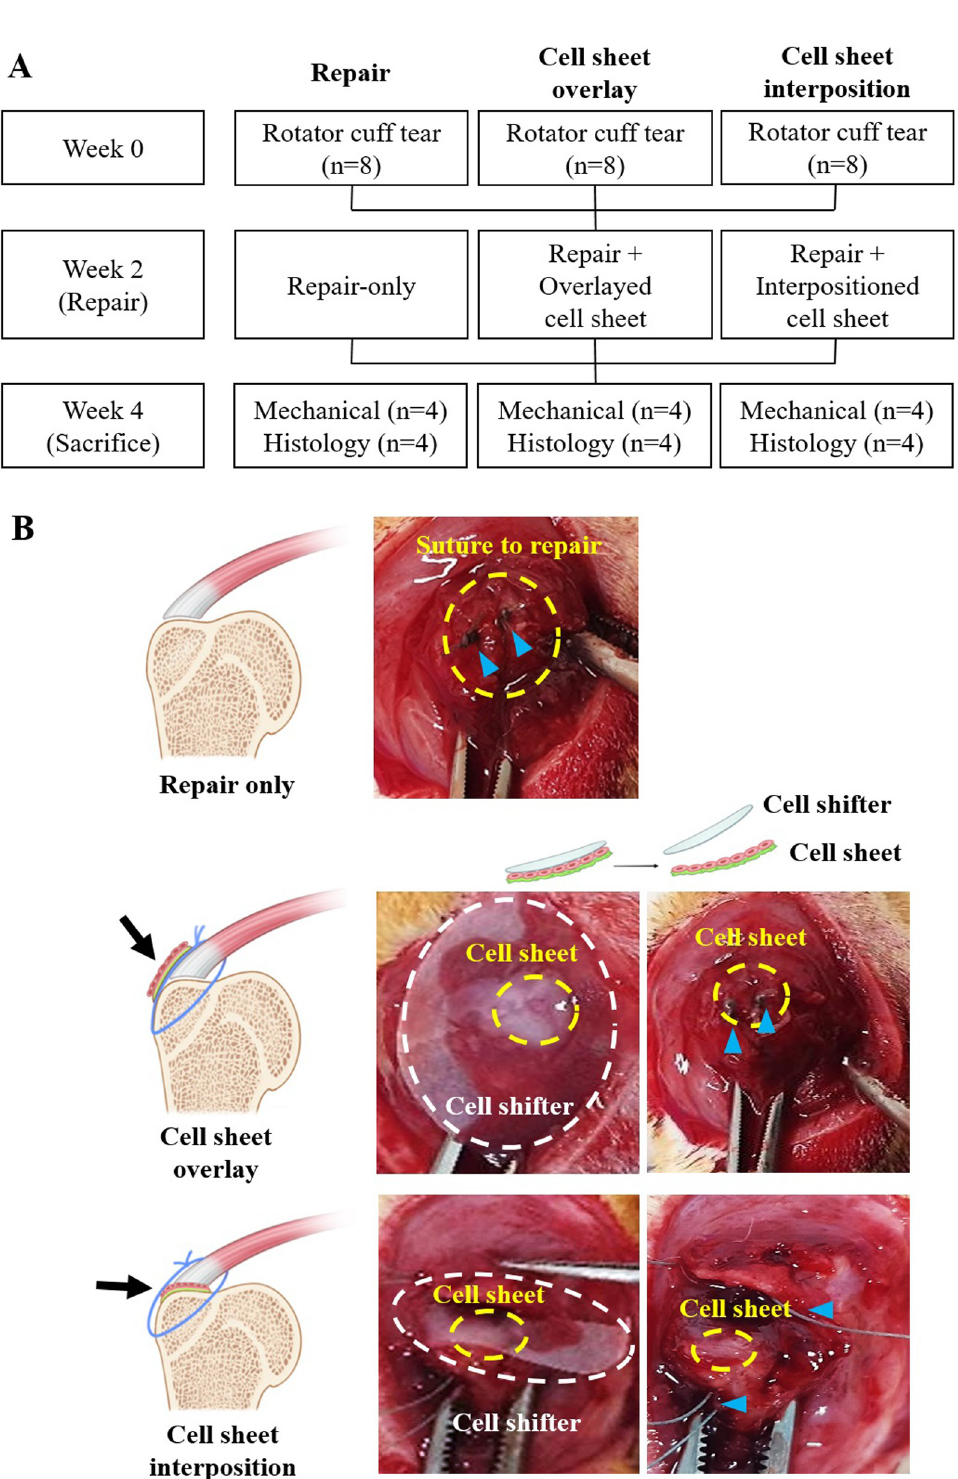
Fig 2. Study design for experiments using rats. (A) The experiment was divided into three groups, with eight rats in each group. (B) The completion of surgical repair and stem cell sheet transplantation. Control group: a surgical repair- only, experimental group: Cell sheet transplantation on top of the repair site (overlay group) or between the tendon and bone (interposition group). The cell sheet is highlighted with a yellow circle in the illustration, and the suturing thread is shown as a blue triangle in the